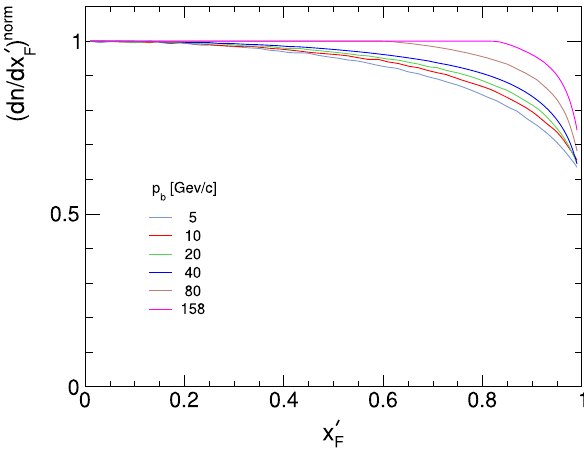
Correspondingly the x (cid:3) progressively suppressed above x (cid:3) Fig. 162.